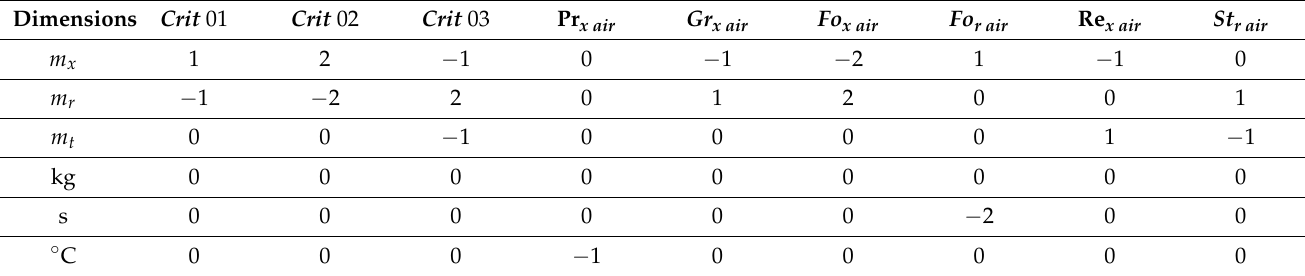
Table 5. The quantities required by the heat transfer correlations between dimensionless numbers (part of matrix B).